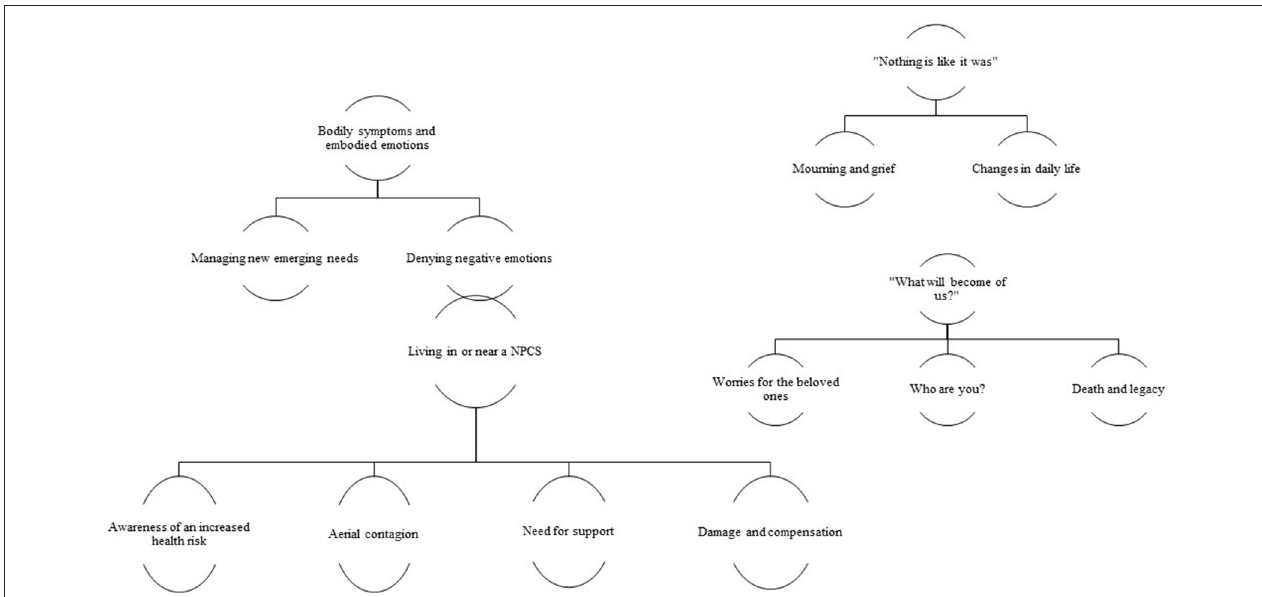
FIGURE 1 | Thematic